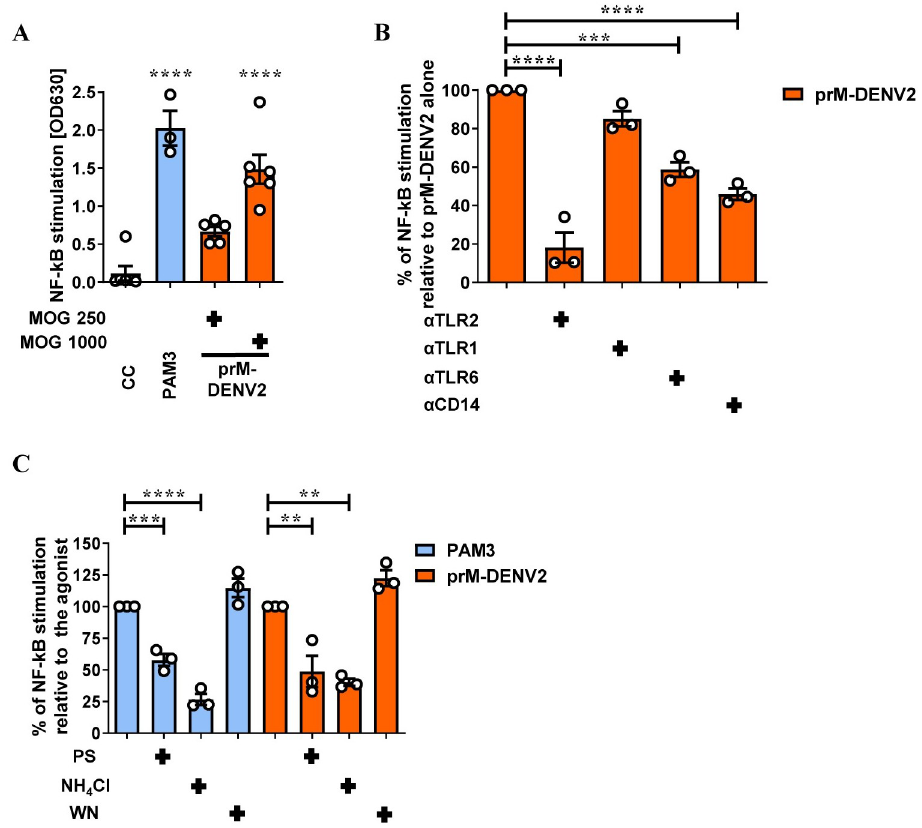
Fig 2. Immature DENV2 virions engage TLR2/6/CD14 to activate NF- κ B. ( A ) NF- κ B activation in HEK-Blue hTLR2 cells (mock)-treated with PAM3CSK4 (PAM3, 50 ng/mL, n = 3) and prM-DENV2 (MOG 250, n = 5; MOG 1000, n = 6) for 24h. ( B ) NF- κ B activation in HEK-Blue hTLR2 cells pretreated for 2h with α TLR2, α TLR1, α TLR6 and α CD14 (15 μ g/mL) before exposure to prM-DENV2 (MOG1000) for 24h, n = 3. ( C ) NF- κ B activation in HEK-Blue hTLR2 cells pretreated for 1h with endocytosis inhibitors pitstop (PS, 60 μ M), ammonium chloride (NH 4 Cl, 50mM) and wortmannin (WN, 2 μ M), before exposure to prM-DENV2 (MOG1000) for 24h, n = 3. NF- κ B stimulation was assessed by QUANTI-Blue, OD values show the induction of NF- κ B. Data represents the mean ± SEM. P values were obtained by one-way ANOVA, Dunnett post hoc test ( �� P < 0.01; ��� P < 0.001; ���� P < 0.0001). n = independent biological experiments. CC: cellular control. PAM3 and prM-DENV2 as a control of their respective blocking/ treatment conditions.